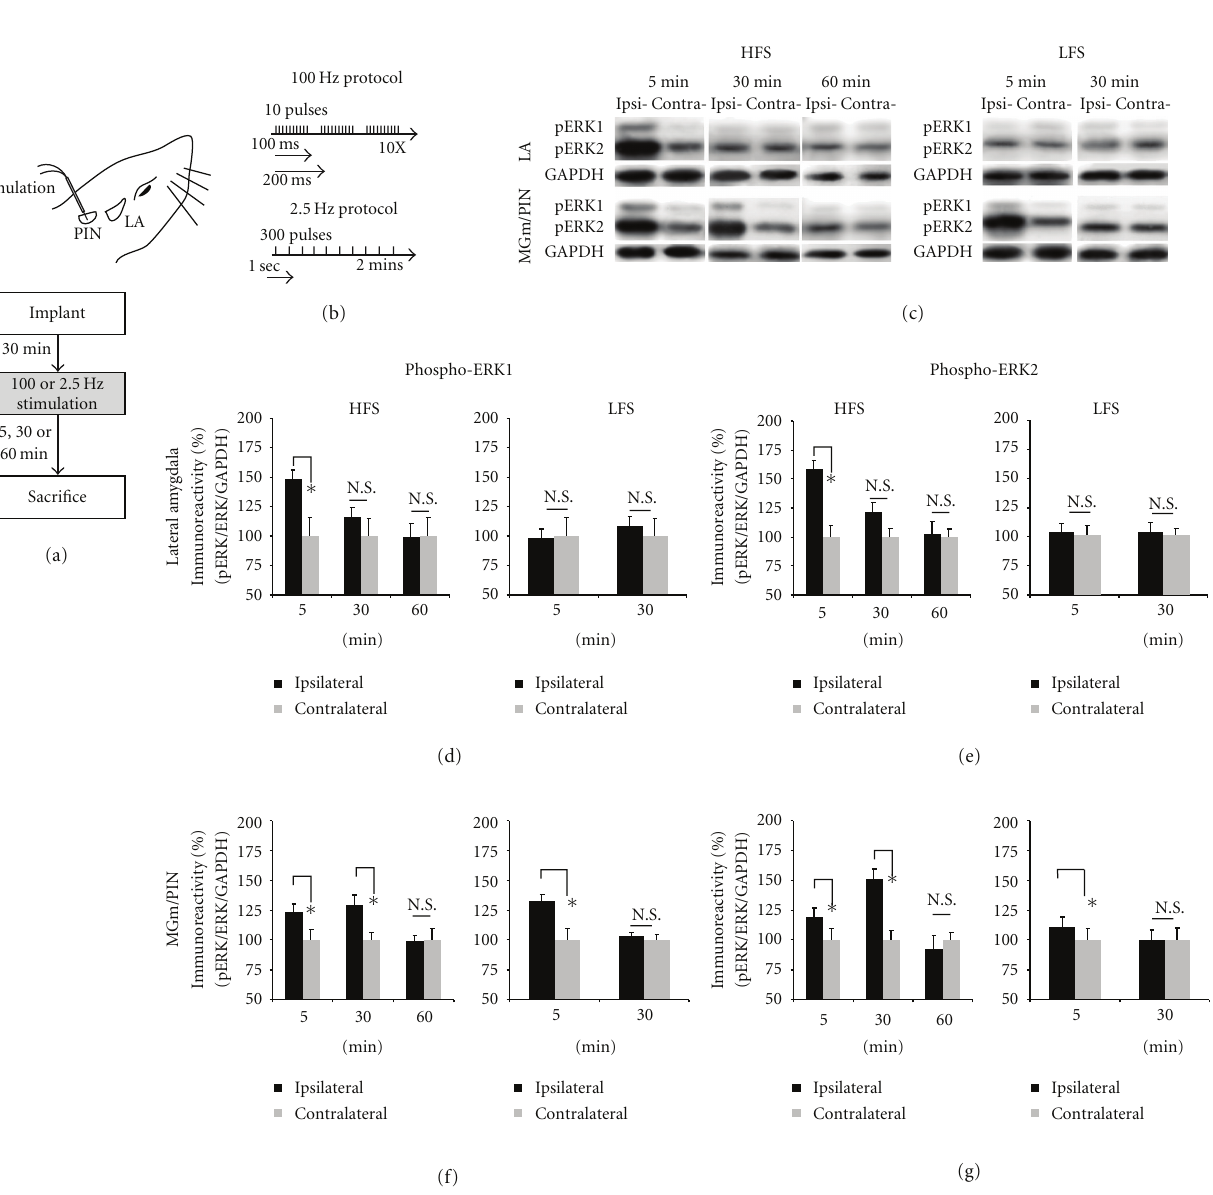
Figure 1: High-frequency stimulation of the MGm/PIN promotes ERK phosphorylation in LA at 5min and in the MGm/PIN at 30min after stimulation. (a) Placement of stimulation electrode and schematic representation of the experimental protocol. (b) Schematic representation of the HFS and LFS stimulation protocols. Anesthetized rats were given HFS or LFS and sacrificed at 5min, 30 min or 60 min after stimulation. (c) Images of Western blots for phospho-ERK1/2 and associated GAPDH loading controls from LA (upper) and MGm/PIN (lower) samples after HFS or LFS. (d-e) Mean ( ± SEM) percent phospho-ERK1/2 immunoreactivity from LA punches taken from